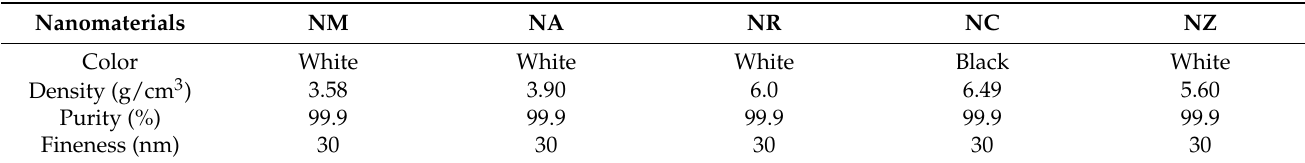
Table 2. Chemical composition of ordinary Portland cement and nano-metal oxides .